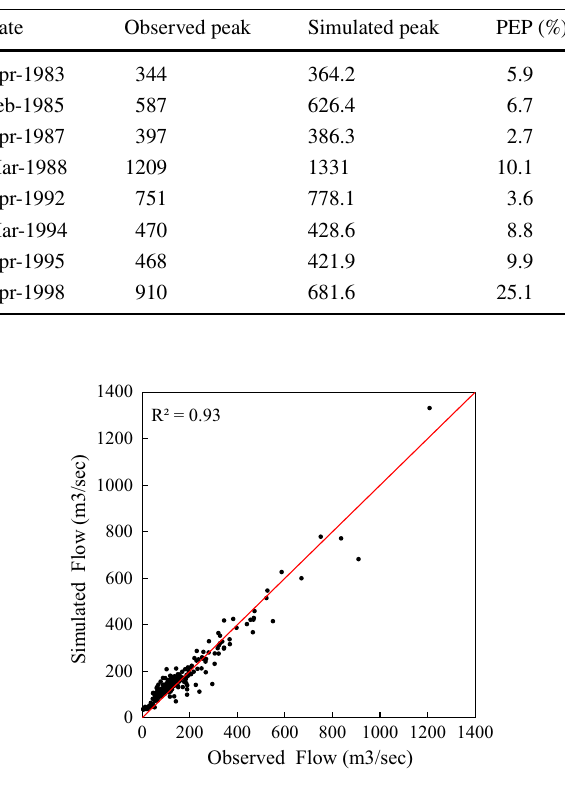
Fig. 13 Monthly observed and simulated runoff at the Hemren dam reservoir for the period 1983–2008 Table 5 The percent error in peak discharges (PEP)